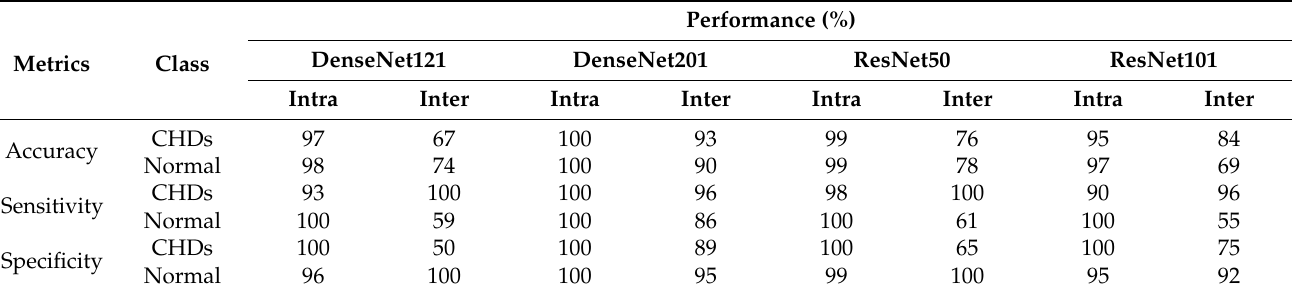
Table 3. Four Classifier backbones for predicting two-class CHDs.